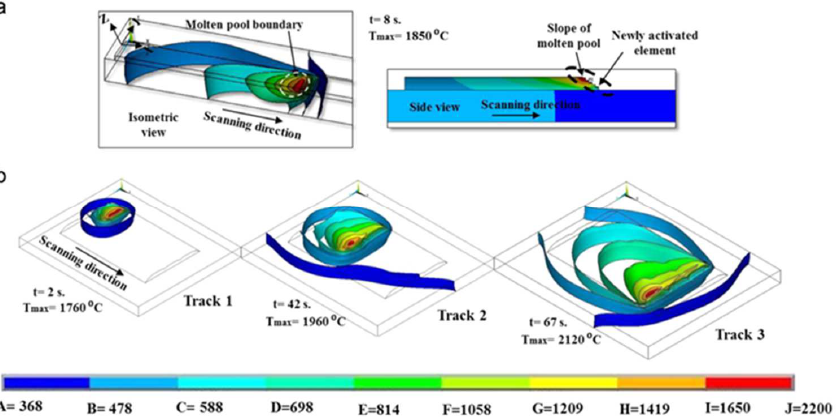
Figure 12. Temperature gradient during the laser cladding: ( a ) single-track laser cladding; ( b ) multi-track laser cladding [4].